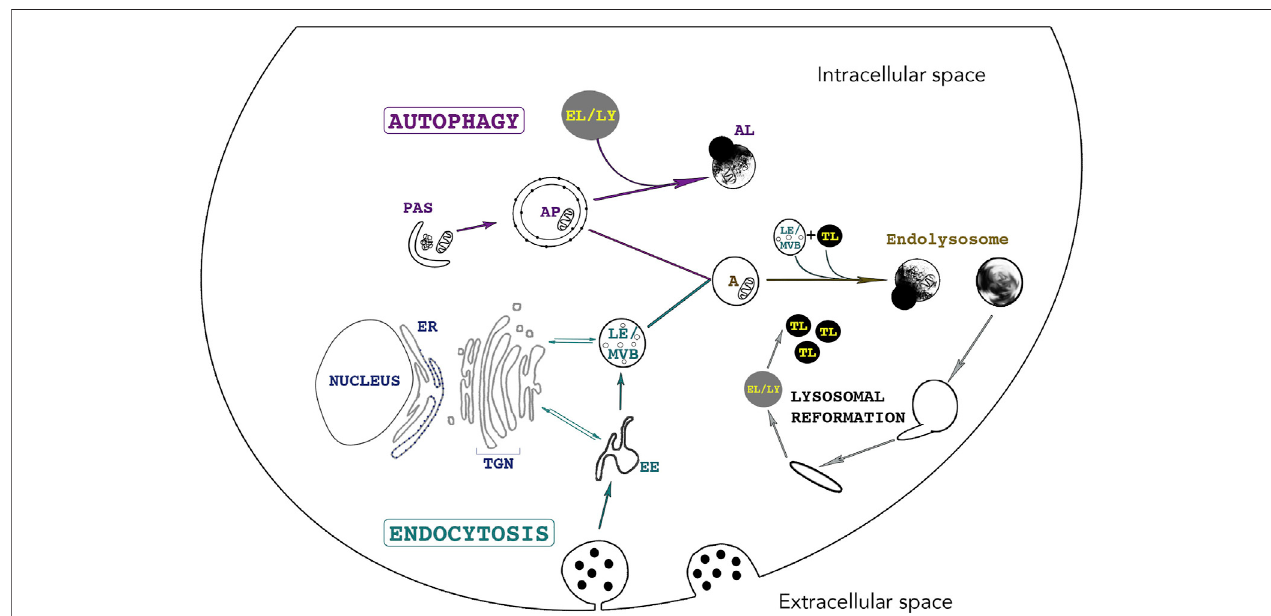
FIGURE2| Thelysosome-anindispensablesharedorganelleforautophagyandendocytosis.AutophagyandEndocytosis,twointimatelylinkedcellularpathways leading to lysosomal degradation of intracytoplasmic and extracellular material, respectively. Autophagy is initiated by the formation of the phagophore also called Pre- Autophagosomal-Structure (PAS) derived from various membranes sources such as the endoplasmic reticulum, the golgi and the plasma membrane. PAS elongation and closure leads to bulk sequestration of intracytoplasmic material in the newly formed double membraned Autophagosome (AP). The AP can either directly fuse with the lysosome (LY) for degradation or can fuse with an endosome (Early Endosome (EE) /Late Endosome (LE)), creating an Amphisome (A). Endocytosis starts with theinvaginationofextracellularmaterialandthebuddingofanendocyticvesiclefromtheplasmamembrane.Endosomematurationisessentialforlysosomalintegrity.EE mature into LE and Multivesicular bodies (MVBs) by continuously maintaining vesicle traf fi cking with the Trans-Golgi Network (TGN). This traf fi cking is crucial for lysosomal integrity as it brings newly synthesized lysosomal enzymes and hydrolases to lysosomes to maintain an acidic pH and ef fi cient degradative functions. Endosomes can directly fuse with lysosomes or with an AP. The fusion of LE and terminal storage lysosomes (TL) creates the principal intracellular site of acid hydrolase activity (EL) (Bright et al., 2016) Tubules emanate from EL (or AL) and lead to the reformation of terminal storage lysosomes, which are hydrolase-inactive and appear as dense bodies in electron